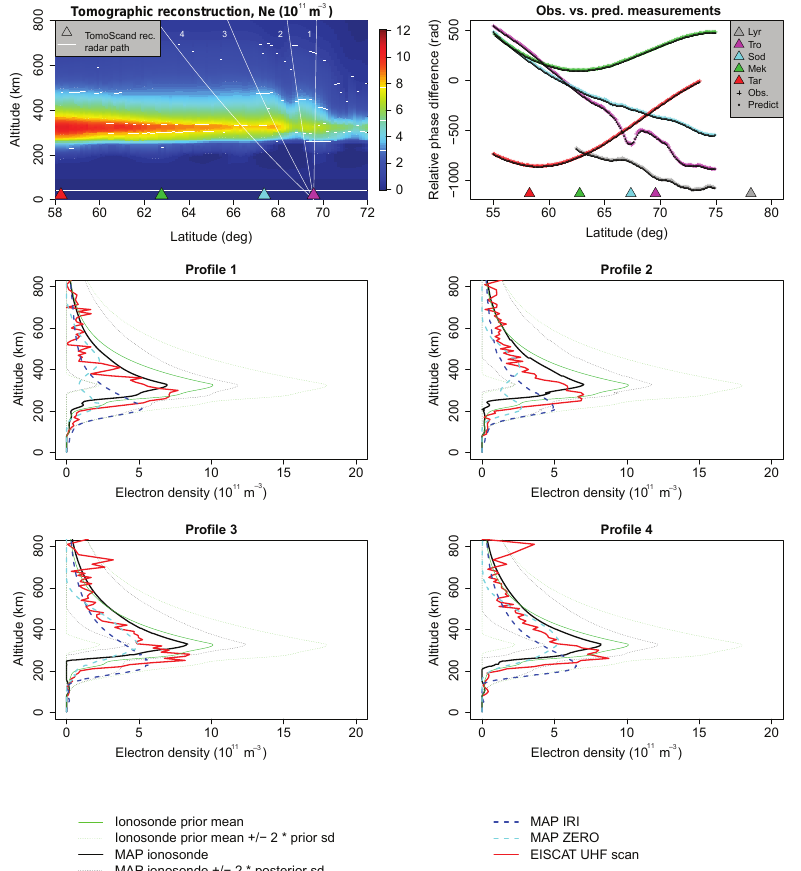
Figure 2. Reconstruction, phase curves and profile comparisons for Overflight I starting on 20 November 2014 at 12:50UTC.